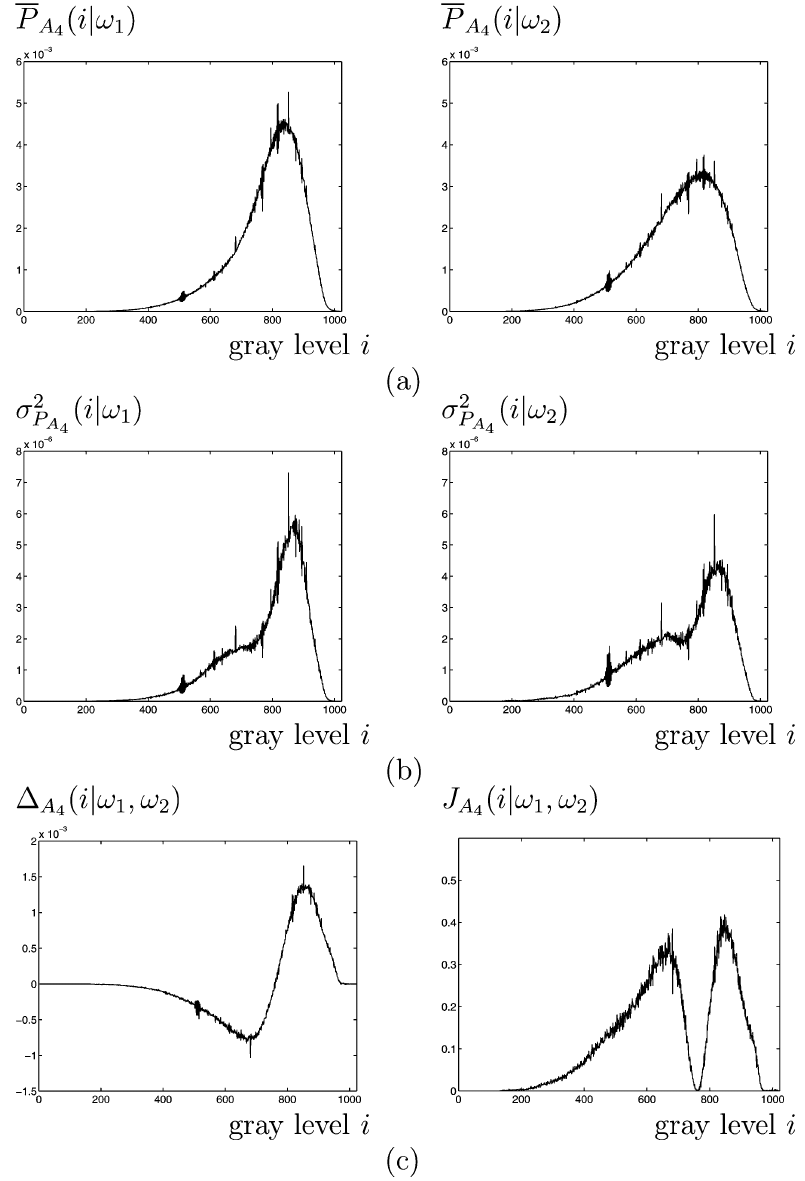
Fig. 2. (a) The average gray level distribution of all nuclear images (within area interval A 4 , 4000 (cid:1) nuclear area < 5000 pixels) of the good P A ( i | ω 1 ) and the poor P A ( i | ω 2 ) prognosis classes of early ovarian cancer. (b) The corresponding class variances of the gray level distrib- 4 4 ( i | ω 1 ) and σ 2 ( i | ω 2 ). (c) The gray level distribution class difference vector ∆ A utions, σ 2 P A P A 4 4 and the level gray distribution Mahalanobis class distance vector J A distributions were computed from the complete non-standardized